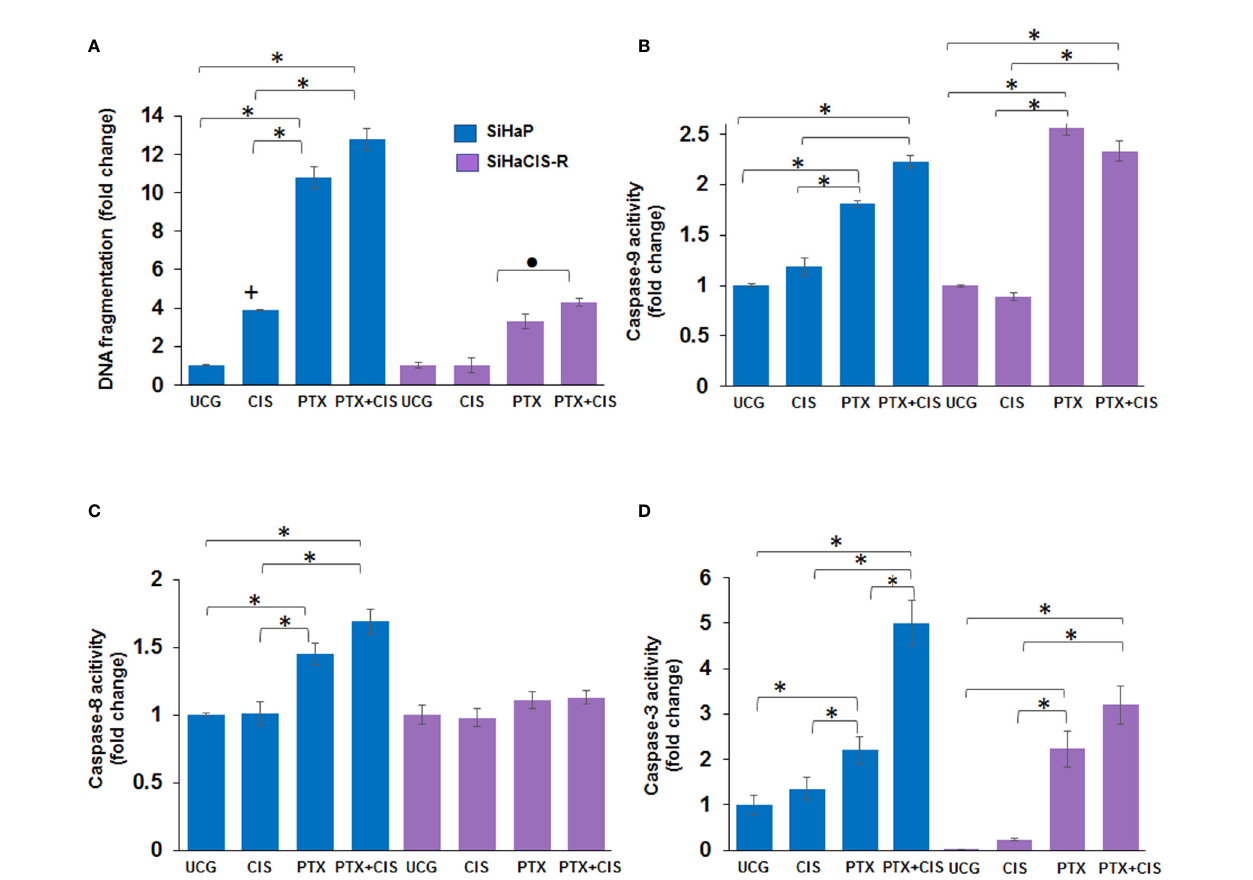
FIGURE 2 | PTX-induced apoptosis and caspase activities in SiHaP and SiHaCIS-R cells. SiHaP and SiHaCIS-R cells were treated with CIS (30 m M), PTX (4 mM), or PTX + CIS (4 mM + 30 m M) for 24 h; then, apoptosis (DNA fragmentation (A) , caspase-9 (B) ; caspase-8 (C) , and caspase-3 (D) activity were determined. Data are expressed as fold change relative to the UCG. * p < 0.001 = statistical signi fi cance after comparison among PTX, or PTX + CIS groups vs. CIS or UCG in SiHaP cell or SiHaCIS-R cells. + p < 0.001 CIS group vs. UCG in SiHaP cells. ● p < 0.001 PTX + CIS group vs. PTX in SiHaCIS-R cells. UCG, Untreated Control Group; CIS, CISplatin; PTX,